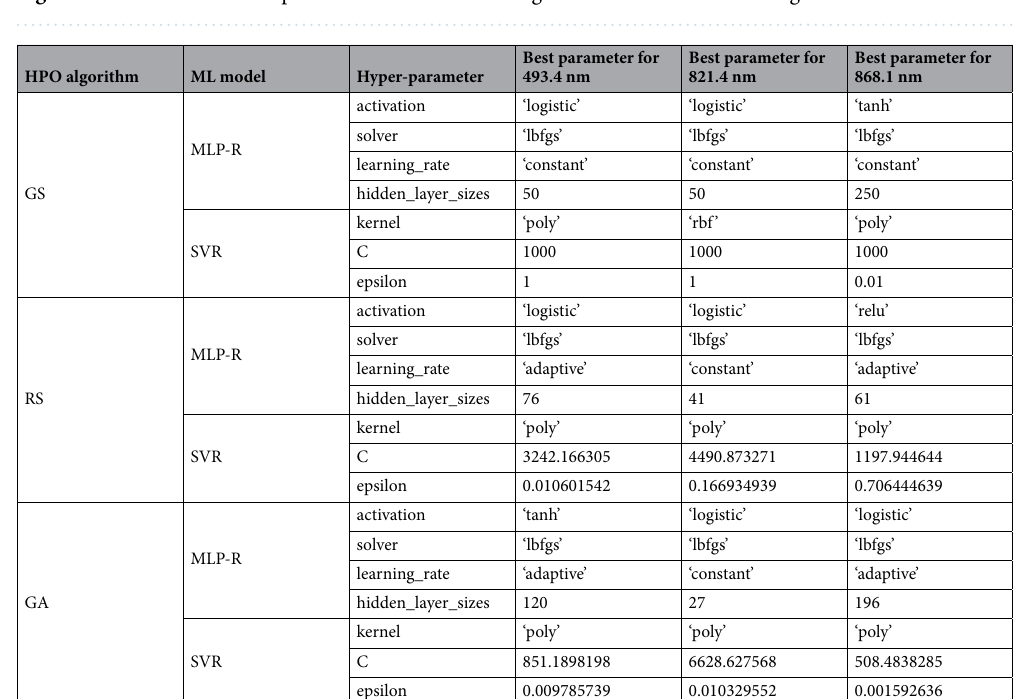
Figure 10. Performance comparison for different HPO algorithms at different wavelengths.